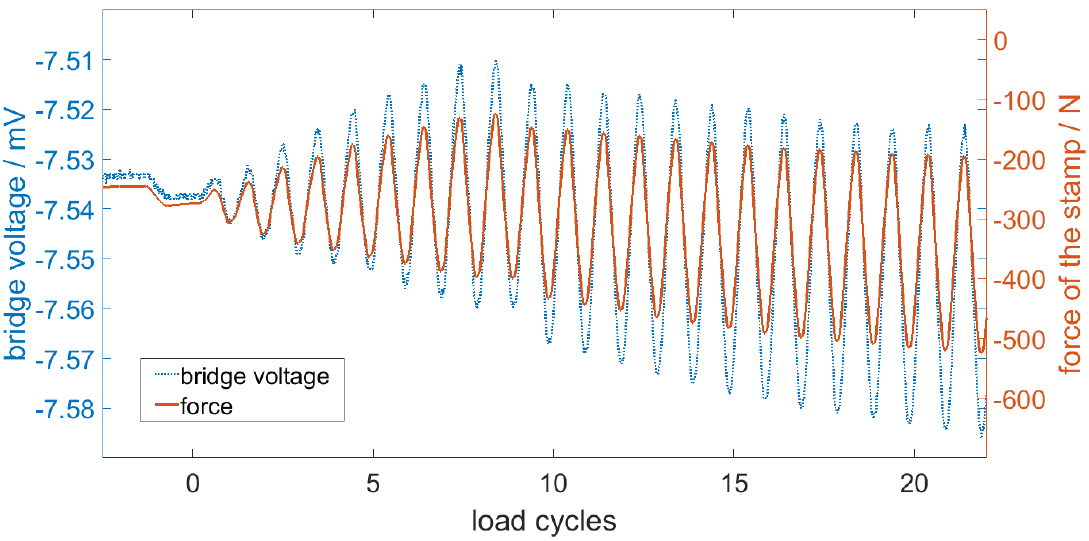
Figure 10. The measurement signal of the bridge and the force of the stamp in a three-point bending test.